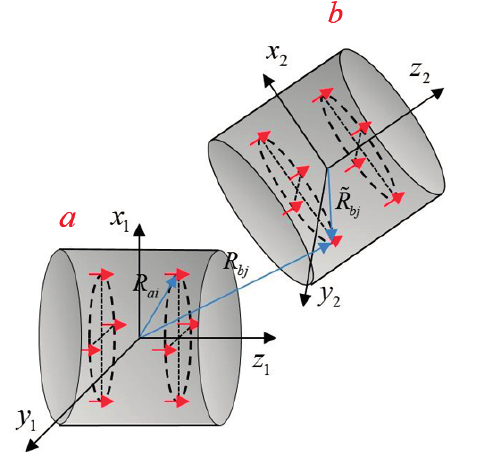
Figure 2. Two coils in their own coordinate